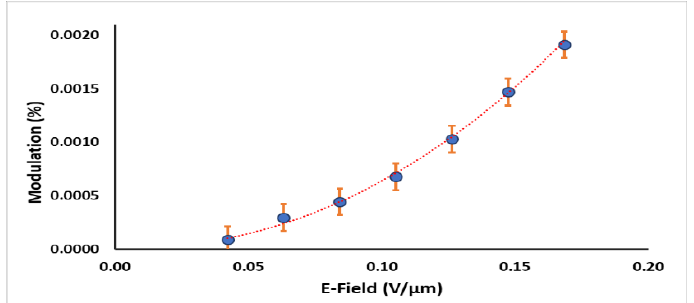
Figure 2. Surface plasmon resonance spectrum of gold nanoparticles in glass (Sample 1, peak at 534 nm) with a particle diameter of about 50 nm.